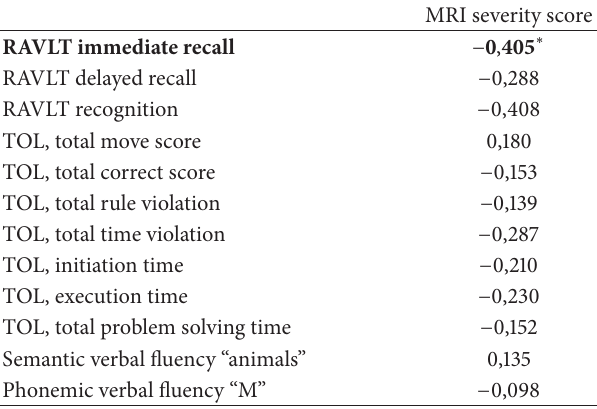
Table 6: Correlation coefficients between MRI severity score and the results of neuropsychological tests in patients with